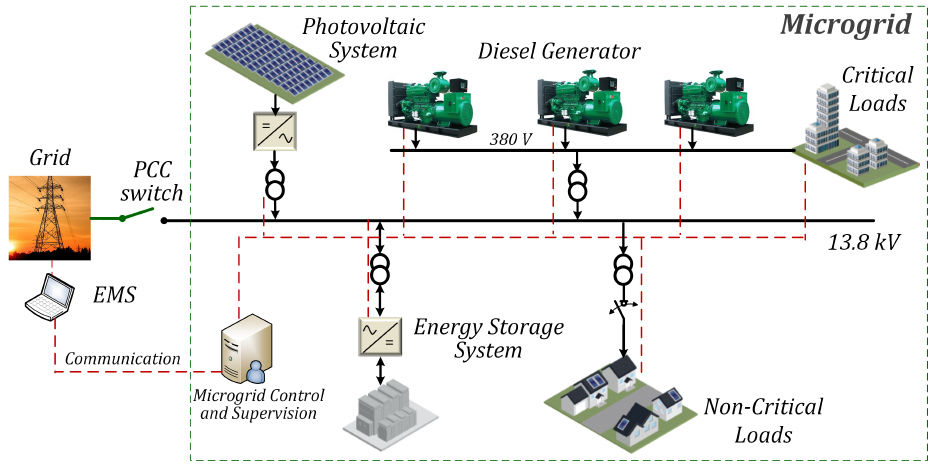
Figure 1. Illustration of the topology proposed for the ASC- µ